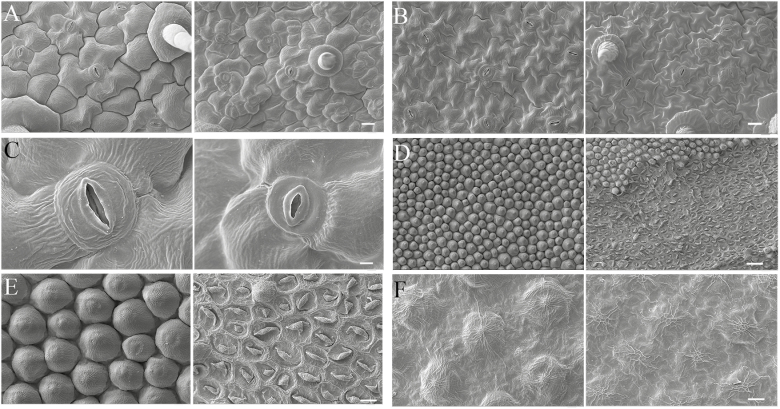
Scanning electron micrographs of the leaves of PaACLB1-B2-silenced plants (left panels) compared with those of control plants (right panels). (A) Leaf abaxial epidermal cells. (B) Leaf adaxial epidermal cells. (C) Guard cells of leaf abaxial surface. (D, E) Petal abaxial epidermal cells. (F) Petal adaxial epidermal cells. Bars=20 µm in (A) and (B); 4 µm in (C); 40 µm in (D); 10 µm in (E) and (F).